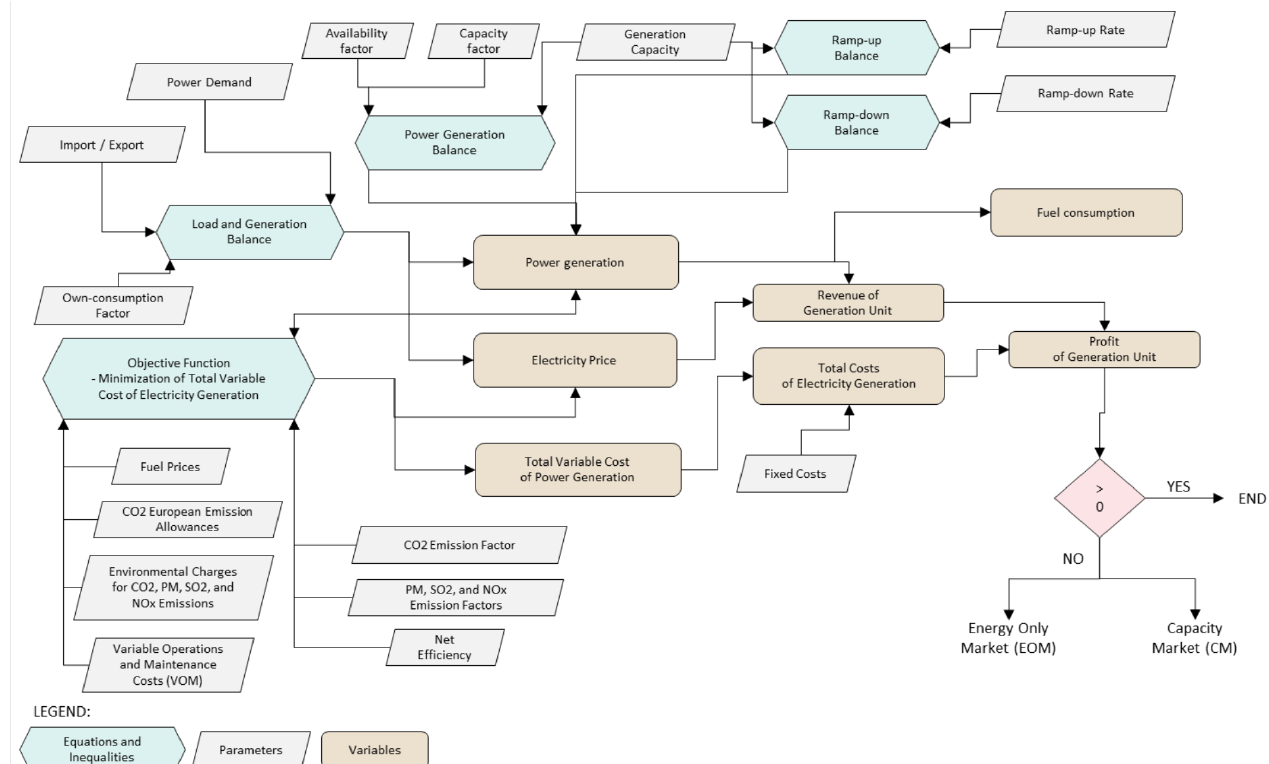
Figure 1. The methodology employed in the